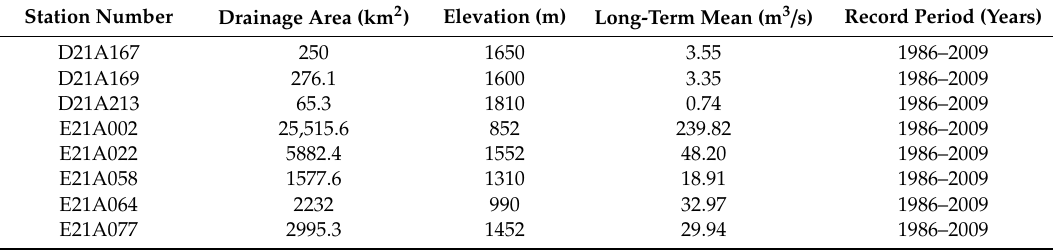
Table 2. Characteristics of streamflow gauging stations in the Upper Euphrates Basin.